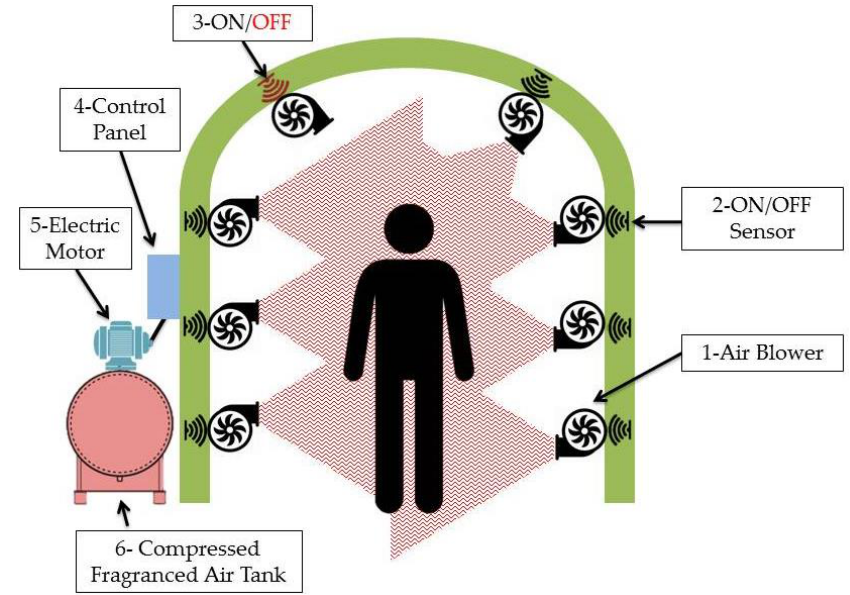
Figure 3. Showing the next section of the gate with a fragranced hot air mechanism.